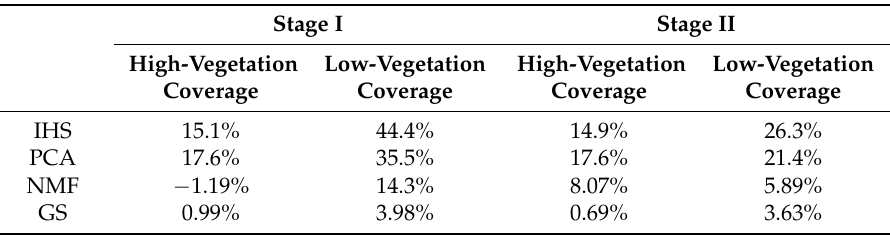
Table 15. Percent improvement in